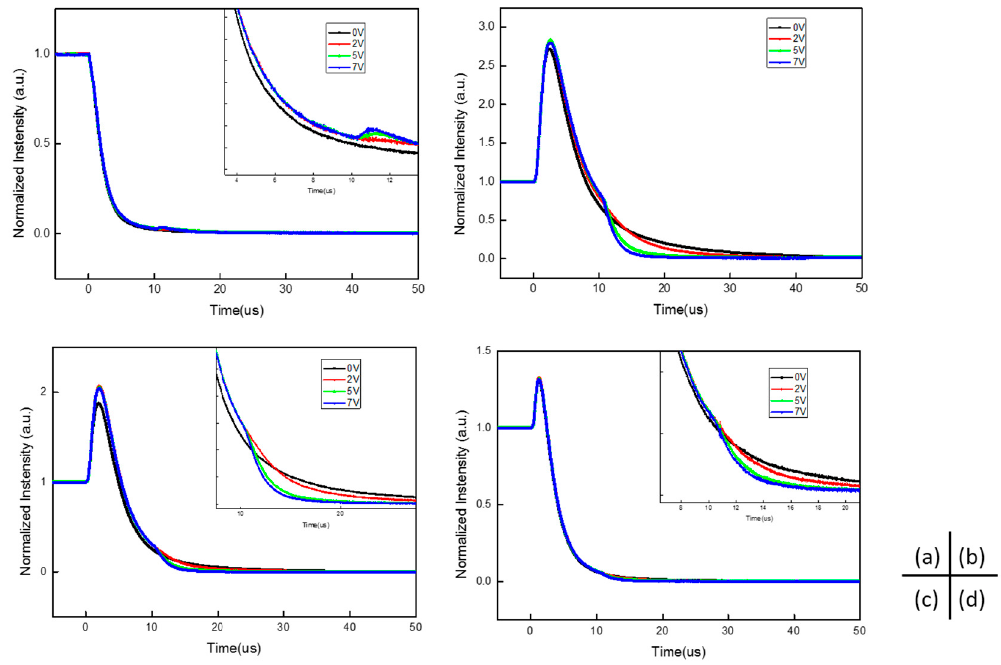
Figure 4. The transient EL curves of 4CzIPN doped devices with different reverse bias; inset is the enlarged view. ( a ) Is for the un-doped devices; ( b – d ) are 1%, 5%, and 10% doped devices, respectively.